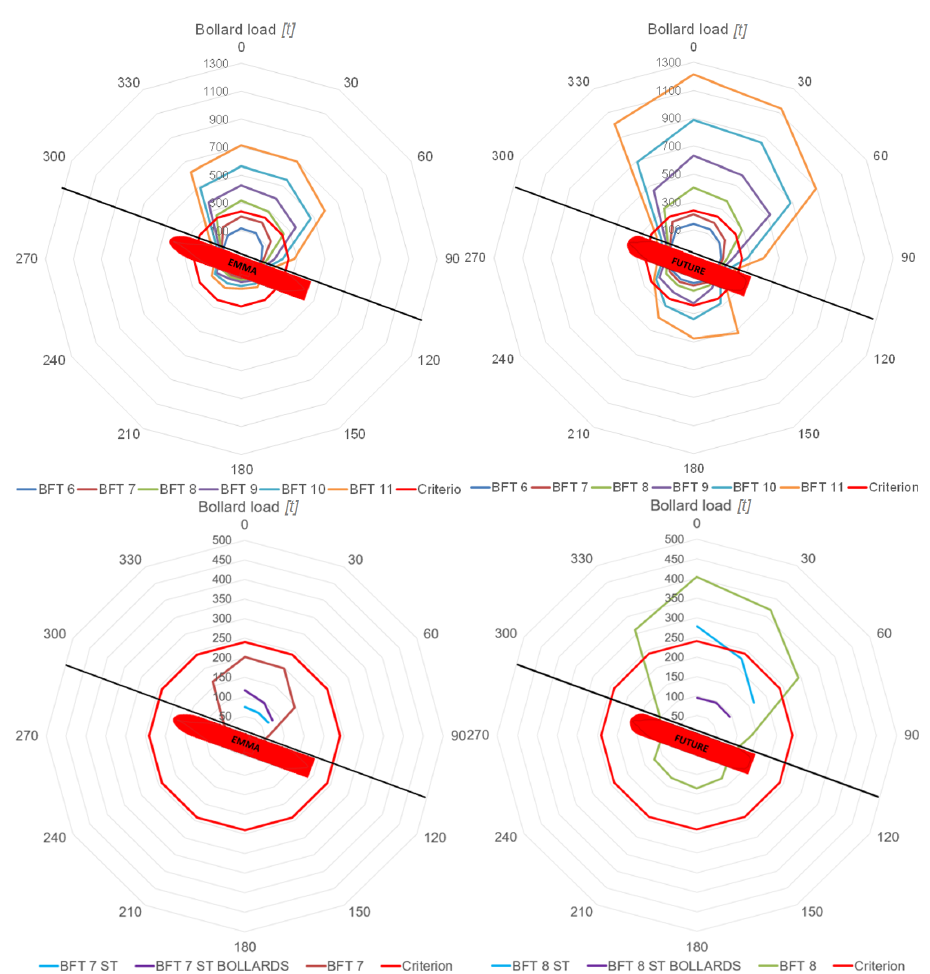
Figure 14. Bollard load results for dynamic wind conditions with and without ShoreTension ®